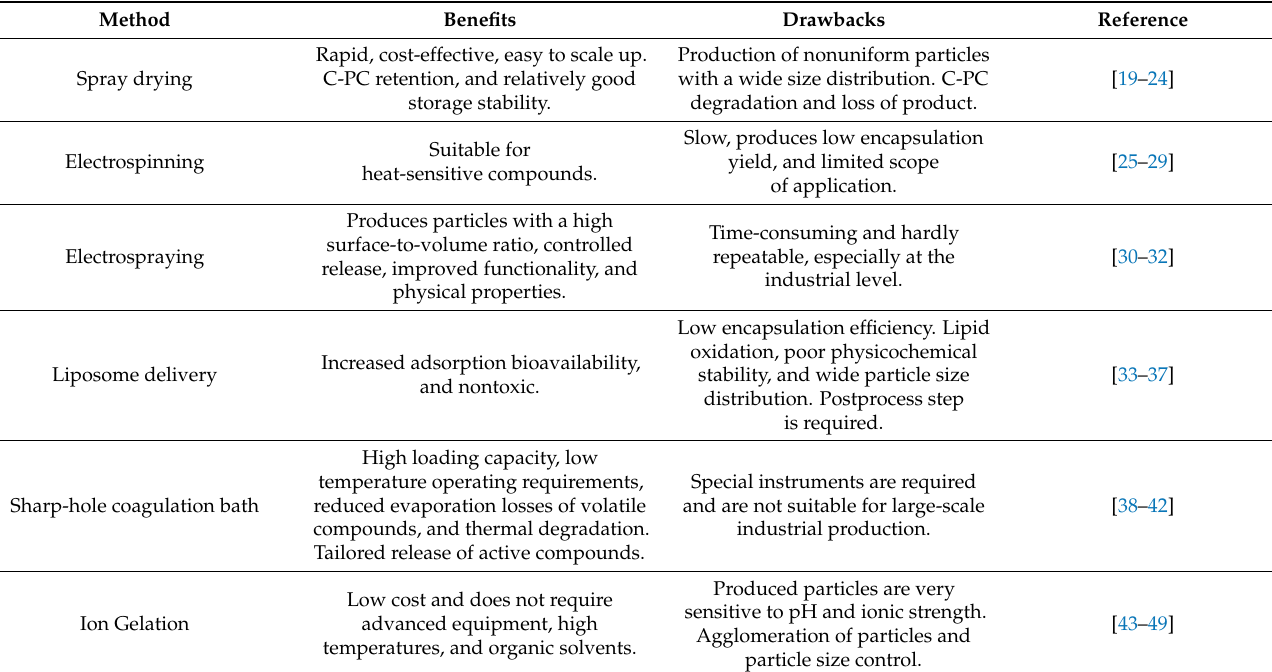
Table 1. Overview of the advantages and disadvantages of various methods for preparing PC